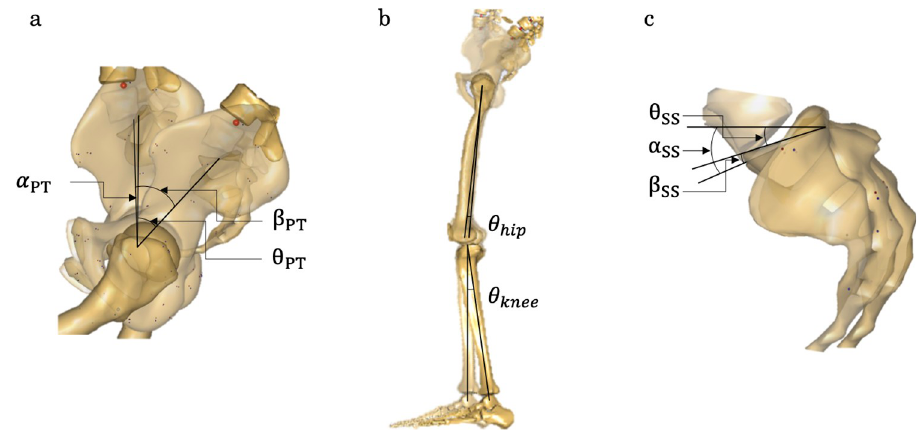
Fig 3. The method for simulating pelvic lower limb alignment in the musculoskeletal models. “ θ ” is the difference between the model default angle “ α ” and the patient’s actual measured value “ β ,” indicating the actual angle to be input into the model. Input “ θ PT ” to be the patient measured value “ β PT ” (a). Input the values of “ θ hip ” “ θ knee ” for hip and knee joint angles (b). Input “ θ ss ” to be the patient measured value “ β SS ”